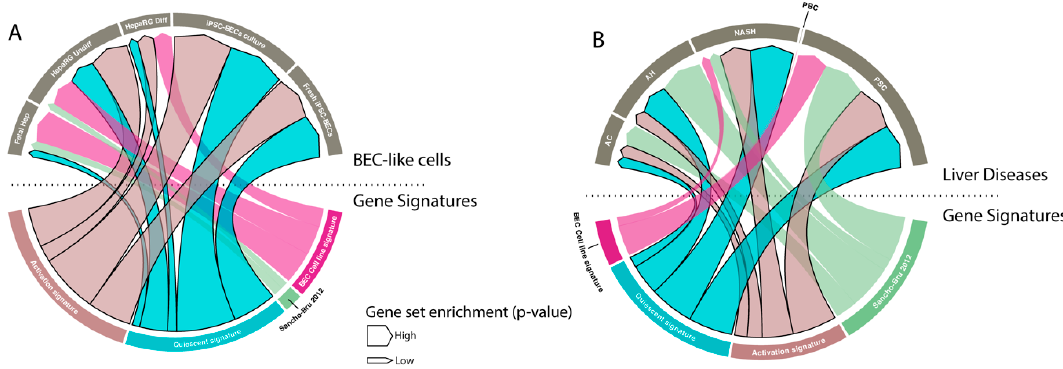
Figure 6. BEC signatures to identify BECs. ( A and B ) Visual representation (chord diagram) of gene set enrichment analysis with our quiescent and activated BEC signatures, Sancho-Bru signature (2012) [44] and BEC cell line signature of Passman et al. 2016 [30] on BEC-like cells and liver diseases (AC: alcoholic cirrhosis, AH: alcoholic hepatitis, NASH: non-alcoholic steatohepatitis, PBC: peribiliary cirrhosis, PSC: primary sclerosis cholangitis). The size of the arrow presents the positive enrichment (significance, -log p-value).